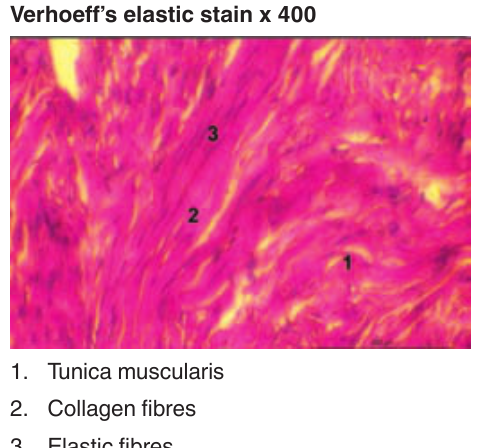
Fig. 6. Longitudinal section of